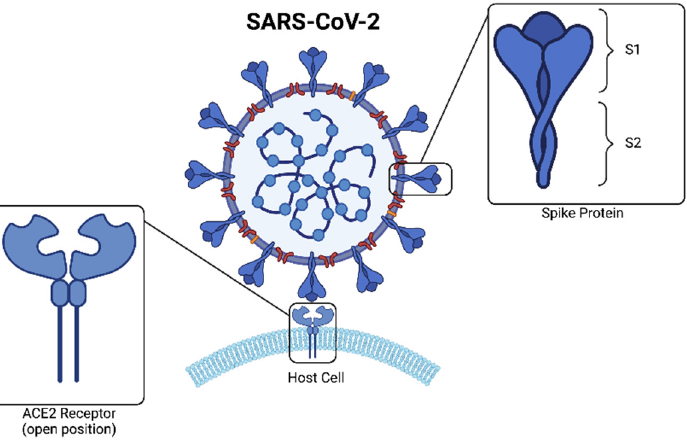
Figure 4. Binding of SARS-CoV-2 to ACE2 receptor: One of the discovered entry routes of the SARS-CoV-2 virus into the host cell is through binding of its spike protein S1 with the ACE2